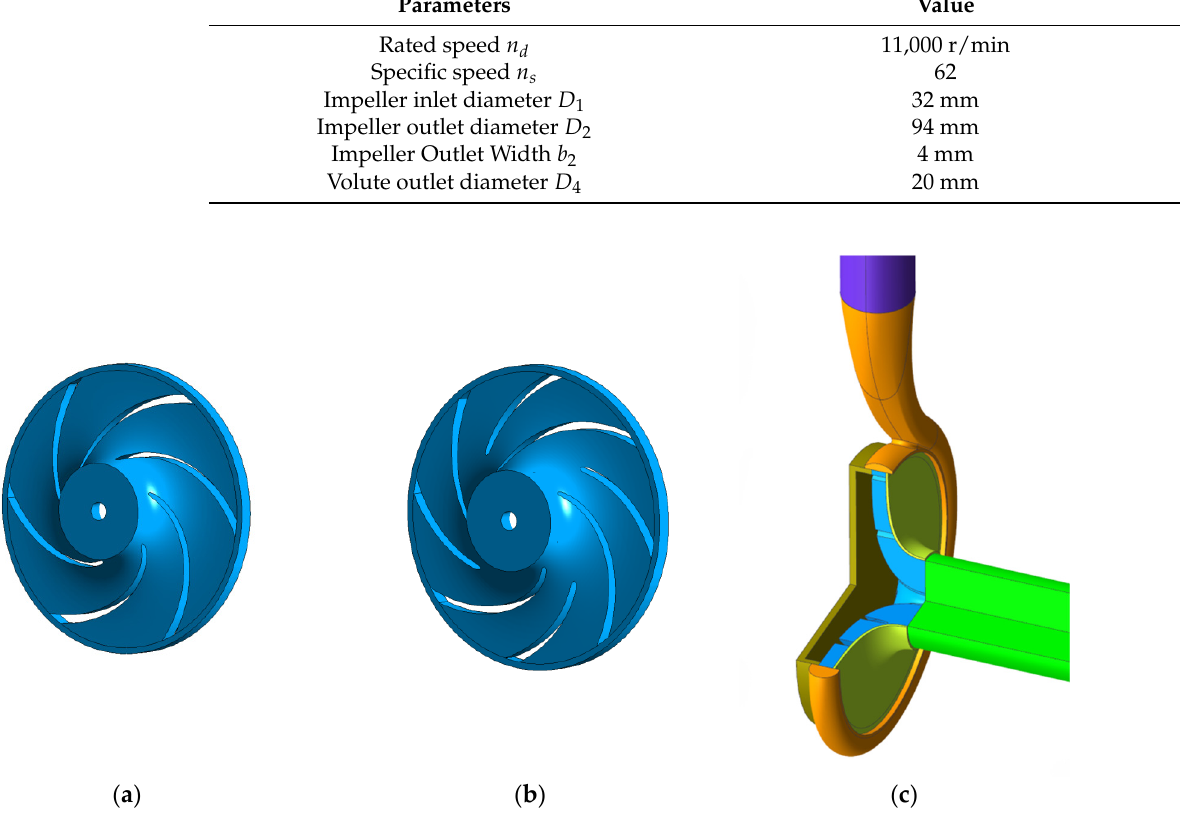
Figure 1. Water bodies of the two impellers and volute of the CFD pump model: ( a ) cylindrical blade impeller; ( b ) splitter blade impeller; ( c ) pump model.